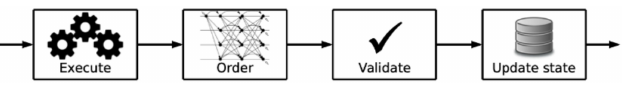
Figure 2. Execute-order-validate